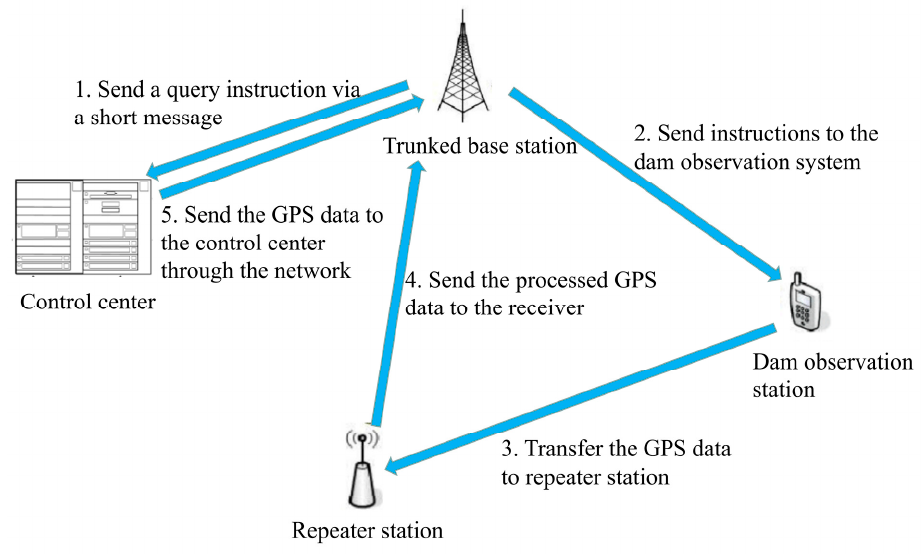
Figure 1. Schematic diagram of the GPS